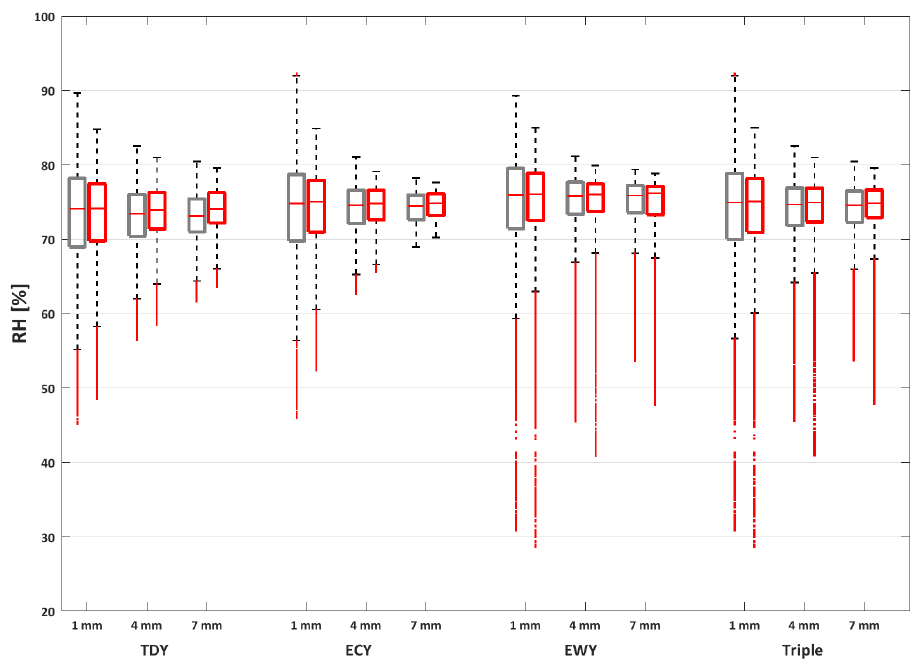
Table 2. Predicted yearly average outdoor T and RH in Gothenburg (affecting the generic buildings) and the 30 years average of Bavaria (affecting the Roggersdorf church).